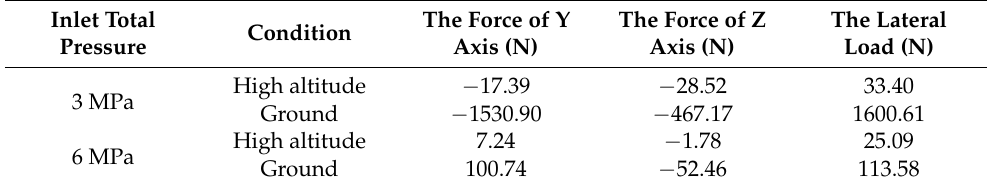
Table 4. Lateral loads under different working conditions.